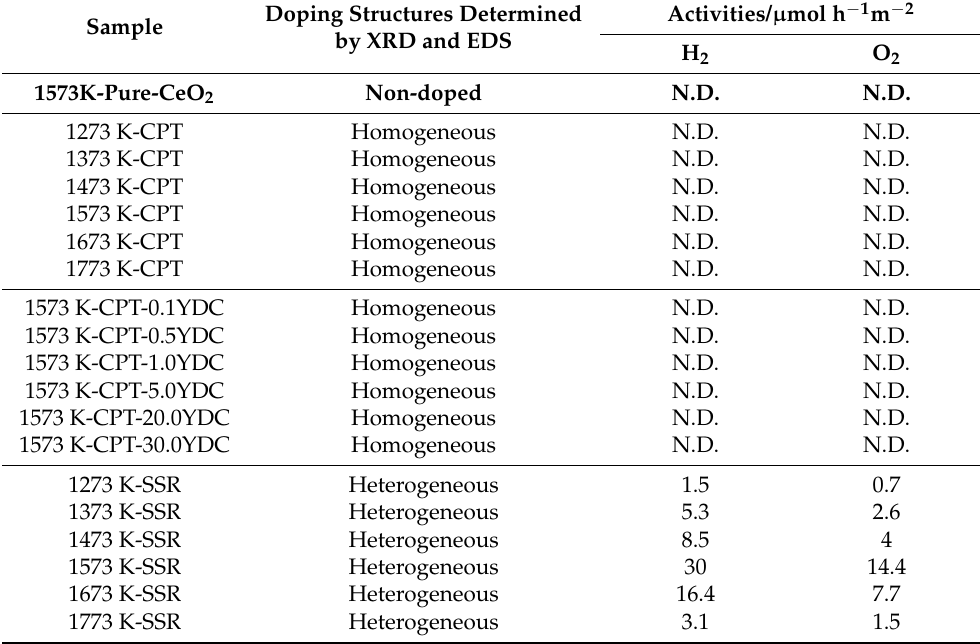
Figure 4. Photocatalytic H 2 and O 2 evolution on RuO 2 -loaded 1573K-SSR without and with light irradiation. Table 3. Photocatalytic activities for overall water splitting on RuO 2 -loaded Y 3+ -doped CeO 2 synthe- sized by CPT and SSR methods at different calcination temperature with various doping